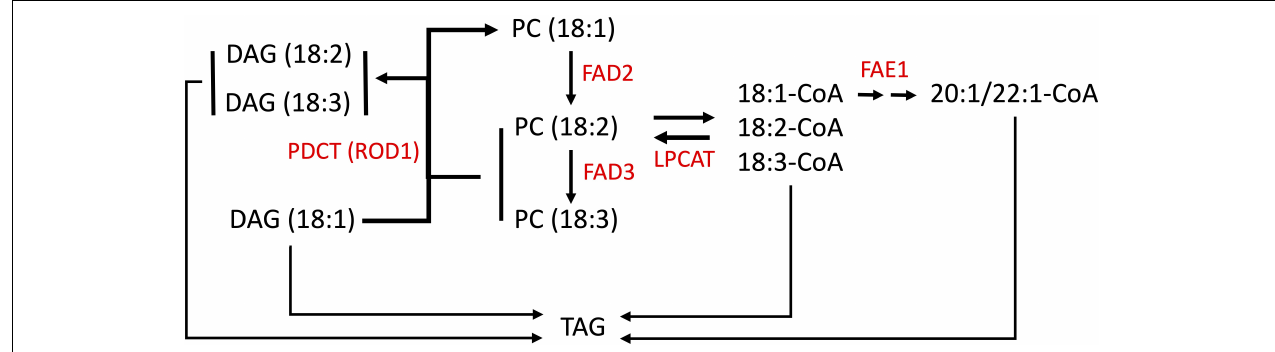
FIGURE 1 | Simplified scheme for fatty acid modification in Brassicas. Fatty acid (FA) elongation of 18:1-CoA is carried out by a protein complex containing the FA elongase, FAE1. Lysophosphatidylcholine acyltransferase (LPCAT) shuttles acyl groups between PC and the acyl-CoA pool. The polyunsaturated FA pathway involves desaturation of 18:1 (esterified to PC) by the FA desaturases, FAD2 and FAD3. 18:1-CoA and acyl-PC are the substrates for FAE1 and the FA desaturases, respectively. PDCT (phosphatidylcholine (PC):diacylglycerol (DAG) cholinephosphotransferase) is also named REDUCED OLEATE DESATURATION (ROD1) that modulates polyunsaturated FA (PUFA) content by interconverting PC and DAG, transferring 18:1 into PC for desaturation, and 18:2 and 18:3 into the triacylglycerol (TAG) biosynthetic pathway thereby increasing PUFA content in TAG (Lu et al., 2009). Choline phosphotransferase (CPT) may also mediate the interconversion of DAG and PC but is not shown here for